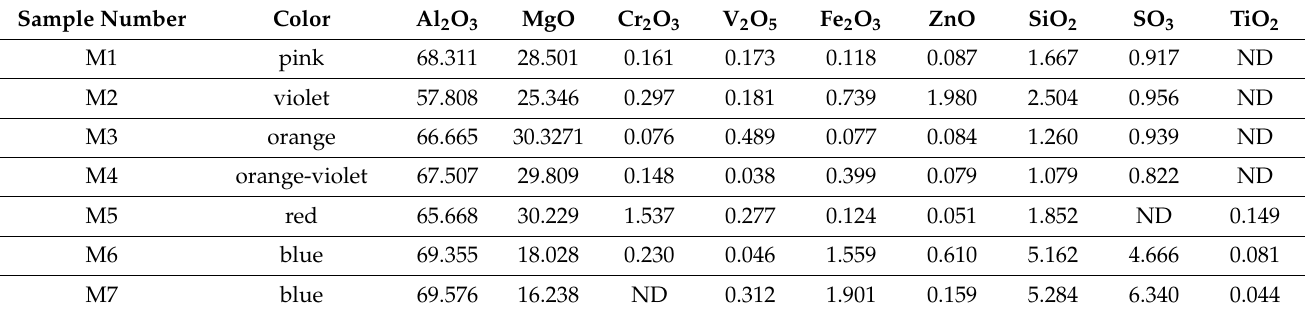
Table 2. X-ray fluorescence spectral analysis data of different colored Myanmar spinels (wt